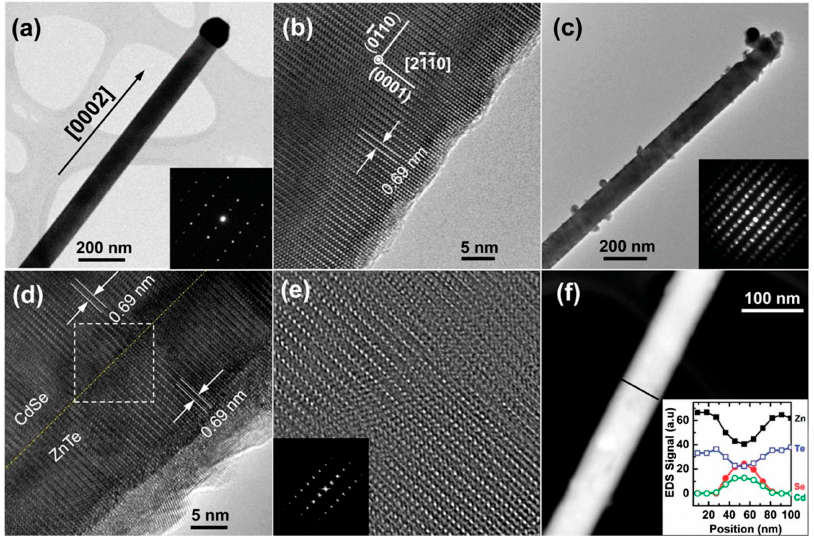
Figure 2. Structural characterization of a CdSe nanowire and CdS/ZnTe core-shell nanowire. ( a ) Low magnification TEM image of an individual CdSe nanowire. Inset: the corresponding SAED pattern. ( b ) HRTEM of a CdSe nanowire demonstrating a single-crystalline, WZ structure. ( c ) A representative TEM image of an individual CdSe/ZnTe core-shell nanowire. Inset: the corresponding CBED pattern. ( d ) HRTEM images of the core-shell interface that display the interplanar spacing and epitaxial growth of the WZ ZnTe shell on the WZ CdSe core. ( e ) Inverse FFT image. Inset: core-shell interface processed from the white, dashed rectangle in ( d ). ( f ) A STEM image of a CdSe/ZnTe core-shell nanowire. Inset: EDS data obtained with a nanoprobe scan along the black line that extends axially across the interface. Reproduced with permission from [26], Copyright 2014, The Royal Society of Chemistry.